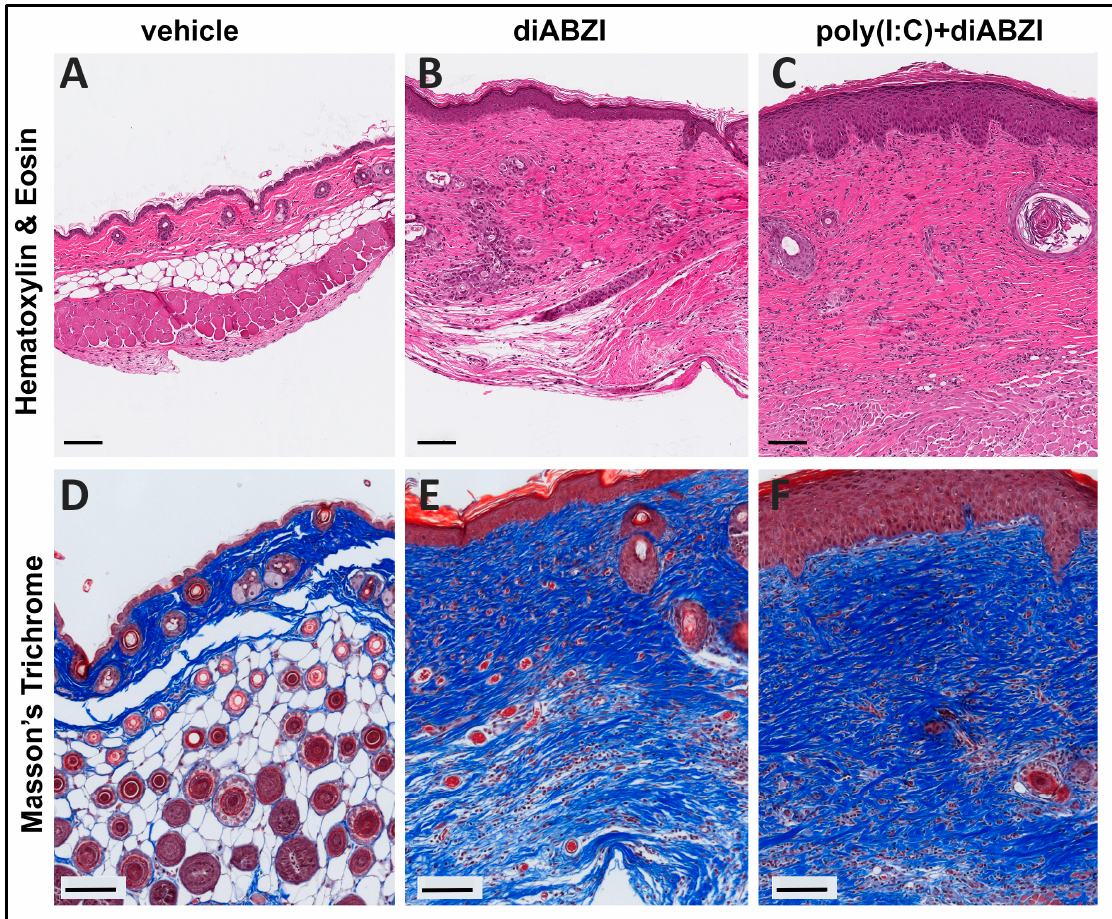
Figure 6. Histopathology of skin lesions in the resolution phase. Representative images of hematoxylin and eosin stained ( A – C ) and Masson’s trichrome stained ( D – F ) skin from vehicle-treated ( A , D ), diABZI-treated ( B , E ), and poly (I:C)+diABZI-treated ( C , F ) mice on day 42. The poly (I:C)+diABZI-treated mice showed persistent epidermal thickening. In comparison, diABZI-treated mice showed significant lesion resolution with fewer epidermal layers and reduced skin thickness. Extensive collagen deposition indicative of dermal fibrosis was present in both groups ( E , F ) (scale bar = 100 µm). 2.4. Poly (I:C) Pre-Treatment Is Associated with an Elevated Cytokine Response to diABZI Poly (I:C) binds endosomal TLR3 and acts as a potent inducer of type I IFNs and the pro-inflammatory cytokines IL-6 and TNF- α . Serum cytokines were measured in the mice from bleeds collected 4 h after injections on day 0 and on day 1. As expected, on day 0, the poly (I:C)-injected mice had high levels of IFN- α , IFN- β , IL-6, and TNF- α compared to the saline-treated controls (Table S2). Following diABZI injection on day 1, the poly (I:C)-pre-treated mice showed significantly higher serum IFN- α , IL-6, and TNF- α levels than those pre-treated with saline (Figure 7). Notably, cytokines were undetectable in sera collected 4 h after 40% PEG300 injection from mice ( n = 3) that were pre-treated with poly (I:C). In addition, no cytokines were detected in the vehicle control group ( n = 3). Thus, intraperitoneal poly (I:C) injection induced a transient elevation in systemic cytokines. However, this temporary systemic inflammation was sufficient to cause a heightened systemic and local response to STING